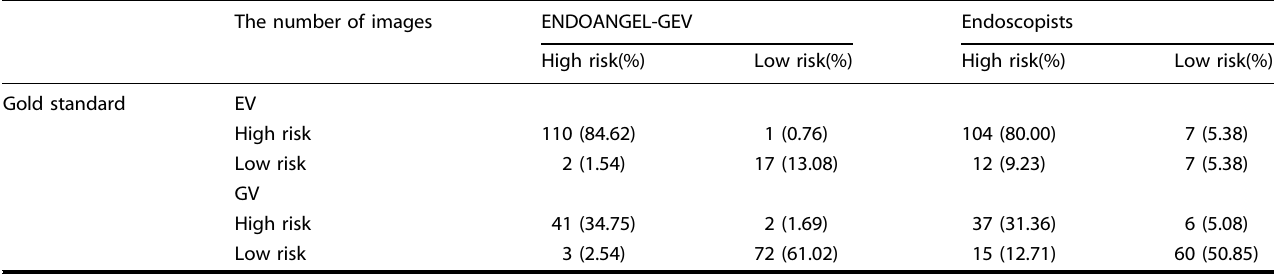
Table 3. Diagnostic value of ENDOANGEL-GEV and endoscopists for risk strati fi cation of EV and GV on Dataset 3 (Prospective